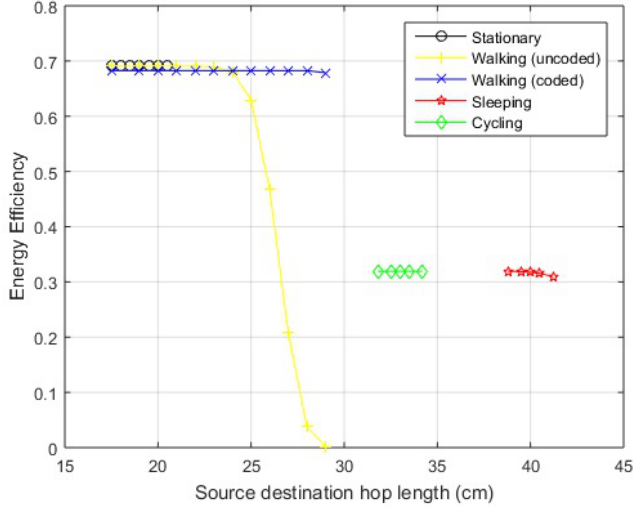
Figure 13. Energy efficiency over posture